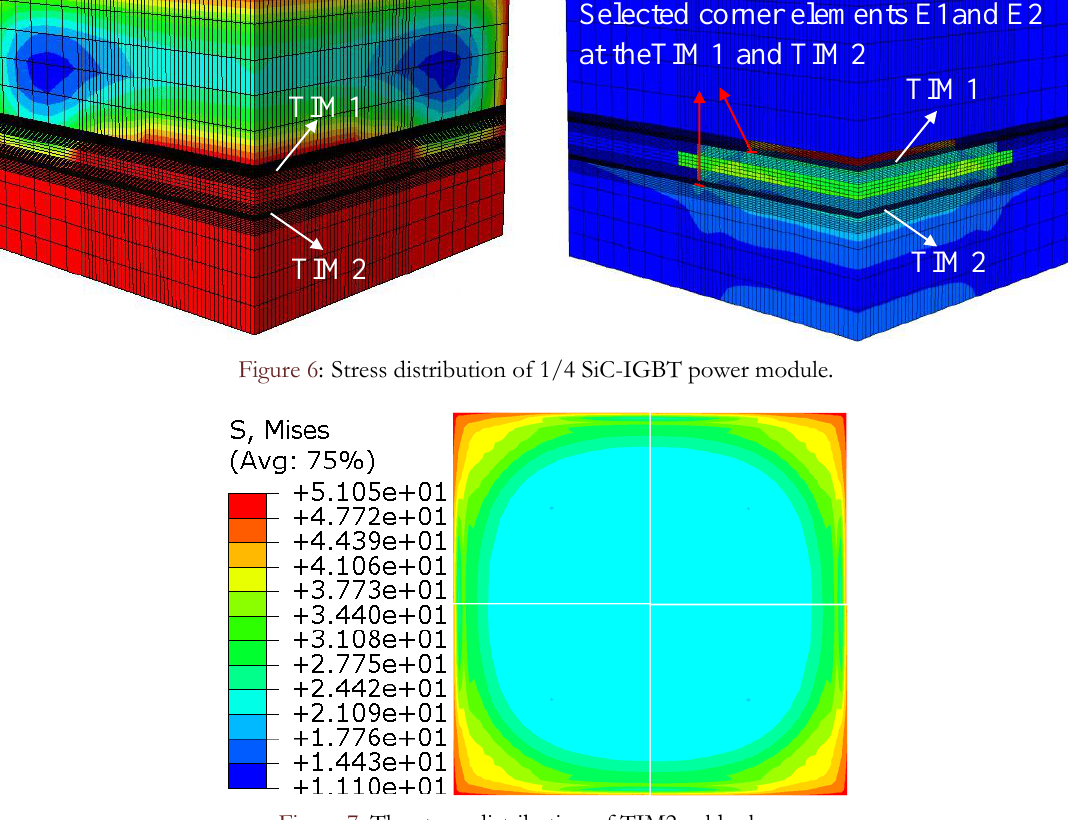
Figure 7: The stress distribution of TIM2 solder layer